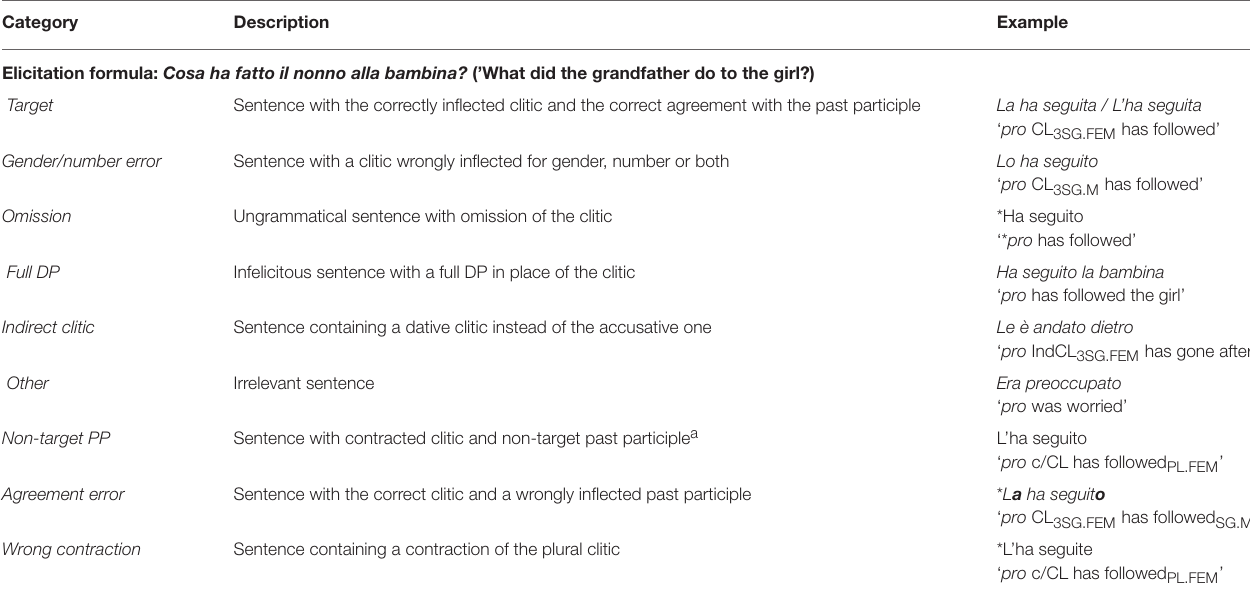
TABLE 3 | Response coding for the clitic task in the Present